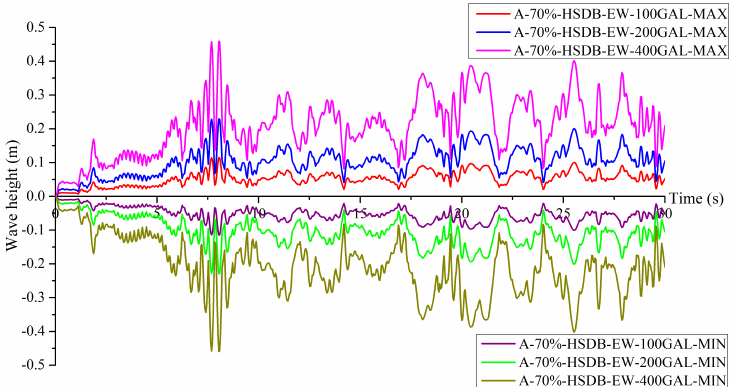
Fig. 3 The maximum and minimum sloshing wave heights for the A-70% condition.